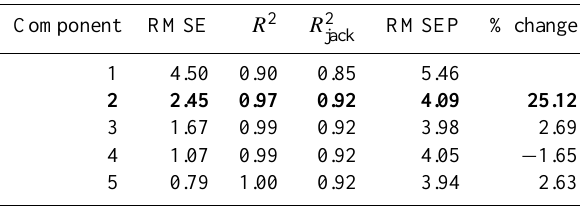
Table 5. Results of the WA-PLS transfer function with the root mean squared error, the apparent coefficient of determination ( R 2 ) , the cross-validated coefficient of determination ( R 2 mean squared error of prediction (RMSEP) calculated by cross- validation, and the reduction in RMSEP (% change). The selected component for the paleo-water depth estimates in cores 030310-C3 and 050310-C4 is shown in